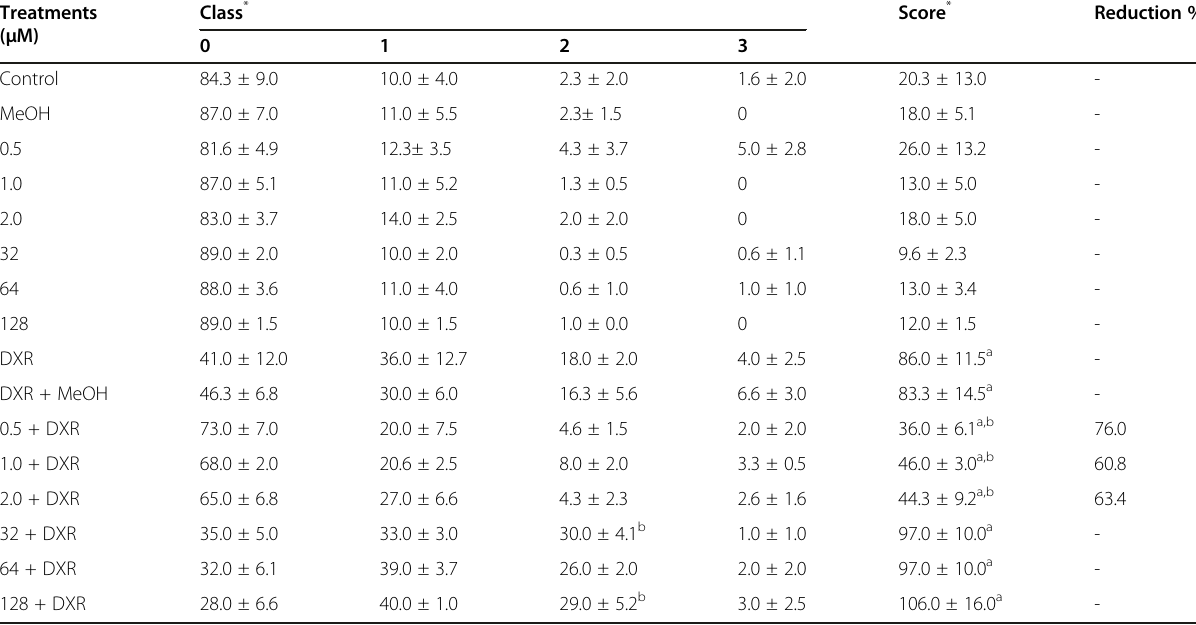
Table 1 DNA migration in the comet assay from V79 cells treated with various doses of HK and/or DXR and their respective controls Treatments ( μ